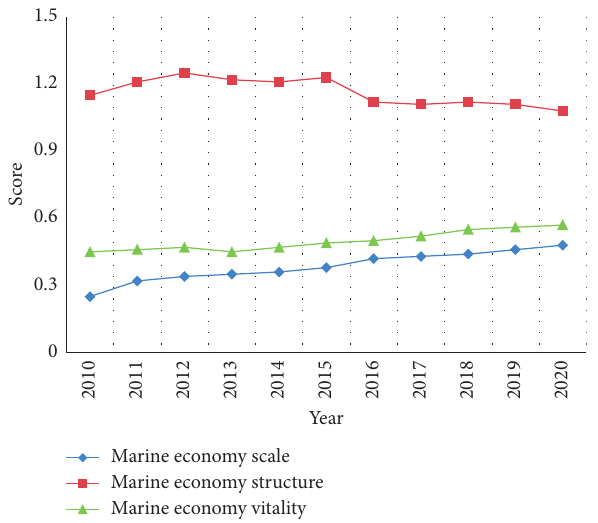
Figure 9: Score of each state layer in the economy subsystem.